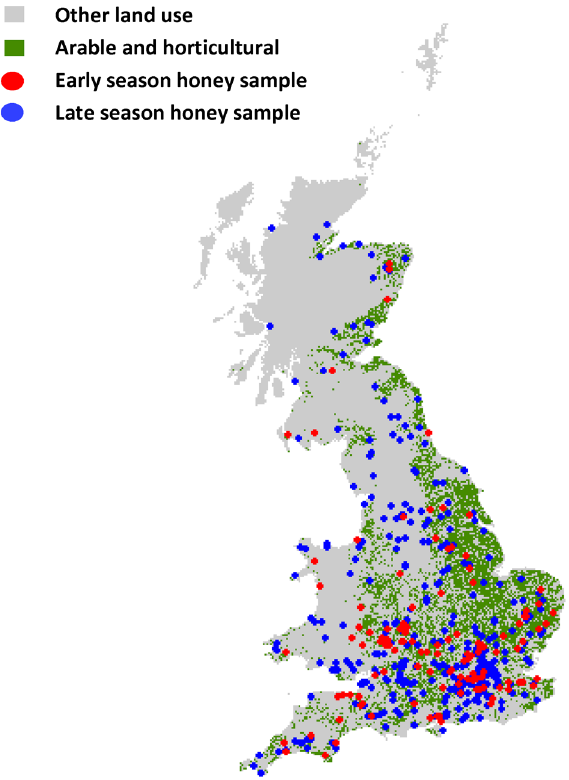
Figure 1. Location of the 527 early (collected in June and before: N = 119) and late (July and after:N = 408) honey samples collected and analysed to determine diet breath of honeybees in Great Britain. Map created in R: Version 3.6.3. (URL